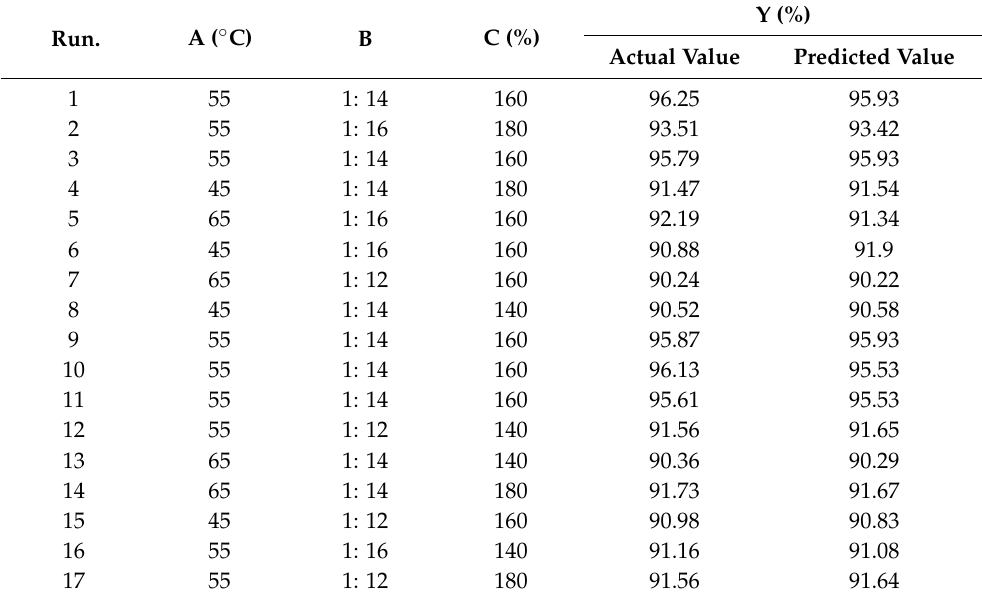
Table 2. Test design and results of RSM.